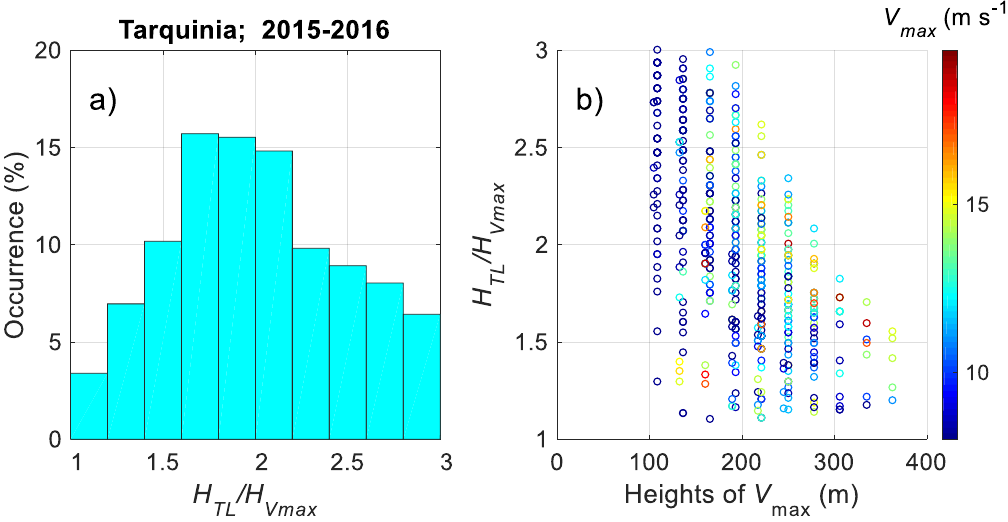
Figure 24. ( a ) Histogram of the ratio HTL / H Vmax and ( b ) values of HTL / H Vmax versus H Vmax . Colours of circles indicate the wind velocity at the LLJ core.